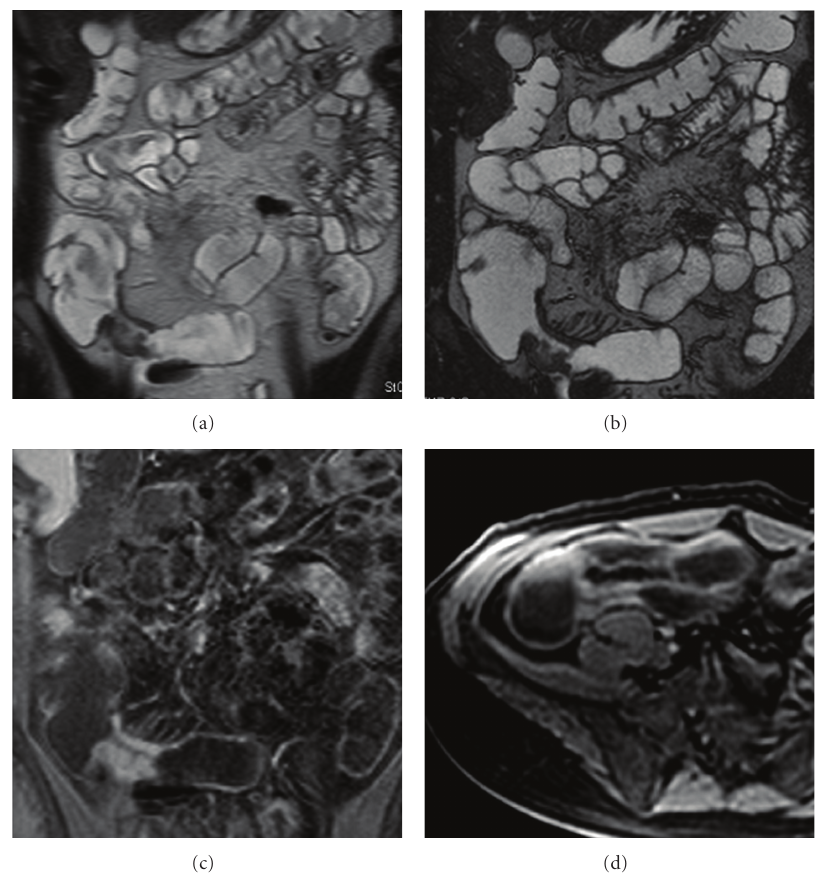
Figure 2: (a) MR enterography, T2 weighted sequence (HASTE, half-Fourier axial single-shot fast spin-echo): relapse of segmental disease associated with segmental wall thickening at the site of previous ileocolic anastomosis; (b) MR enterography T2 weighted sequence (TrueFISP, true fast imaging with steady-state free precession) delineated profiles of segmental wall thickening and mild comb sign; (c-d) MR enterography, T1-weighted sequence (VIBE, volumetric interpolated breath-hold examination): postcontrast homogeneous enhancement of the intestinal wall suggesting a fibrotic